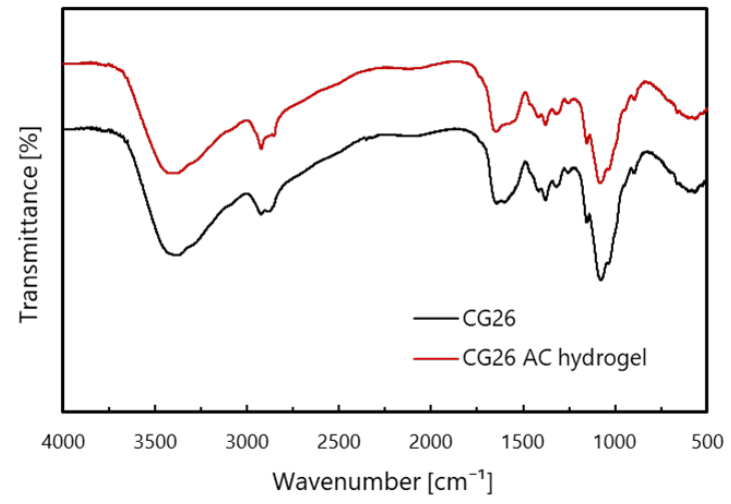
Figure 2. FT − IR spectra of CG26 before autoclaving and CG26 AC hydrogel.